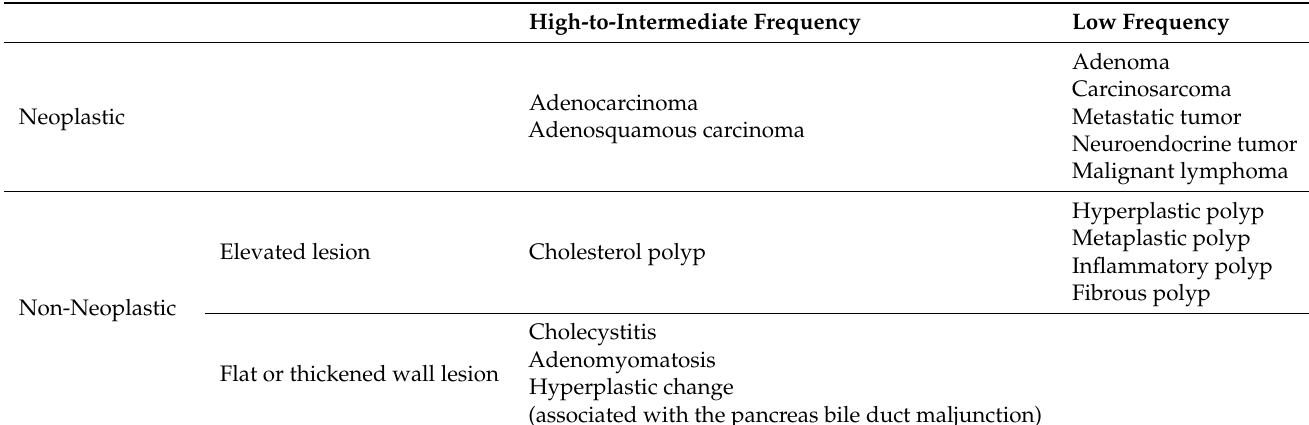
Table 1. Classification of gallbladder